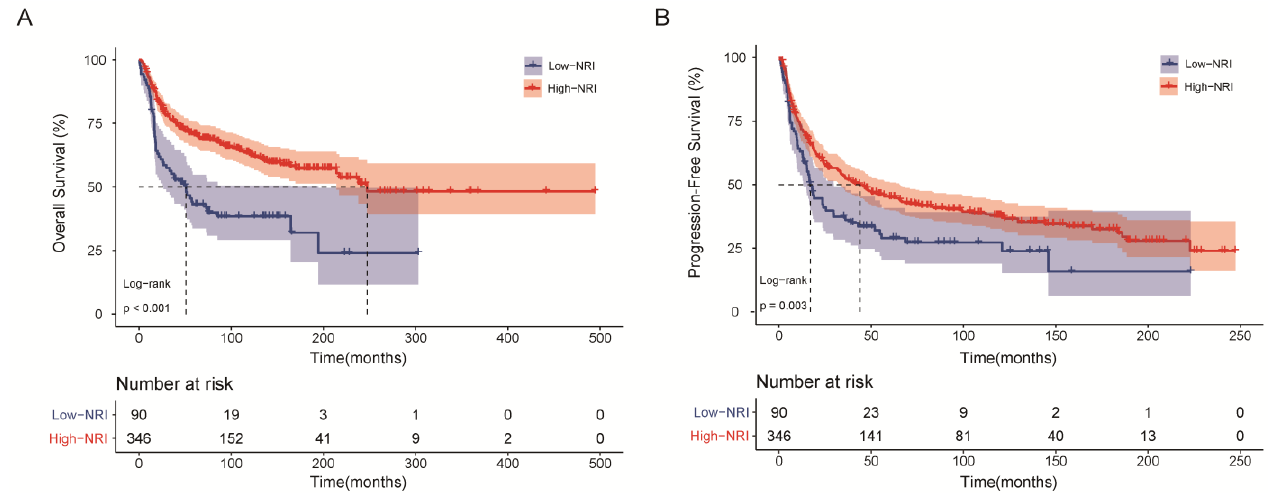
Figure 1. Kaplan–Meier survival curves of HNSTS patients for the whole cohort according to NRI. ( A ) Overall survival; ( B ) Progression-free survival. The log-rank test was used to compare curves. NRI: nutritional risk index.